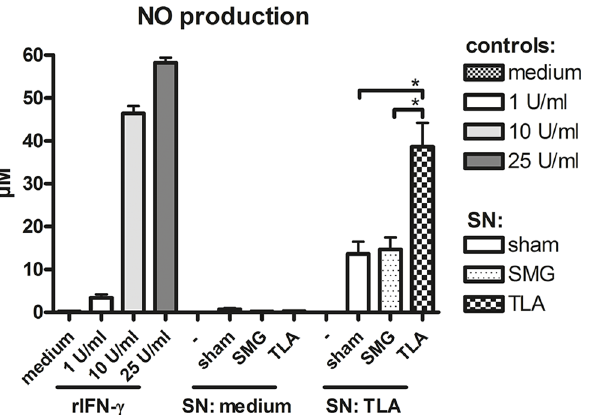
Fig 6. Nitric oxide production. Murine macrophages (RAW264.7) were incubated for 24h with supernatants (SN) of TLA-restimulated (TLA) or unstimulated (medium) splenocytes obtained on day 34. Different concentrations of recombinant IFN- γ (rIFN- γ ) or medium alone served as controls. NO concentrations were measured with a Griess assay. Results represent data of three independent experiments. Data are expressed as mean ± SEM. * p <